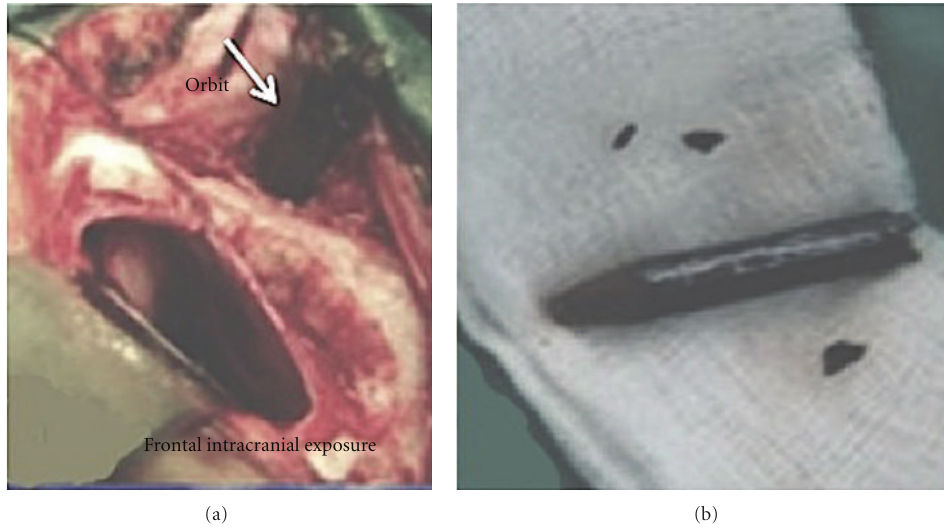
Figure 3: Intraoperative photos demonstrating the foreign body after surgical exposure (a, arrow) and after removal